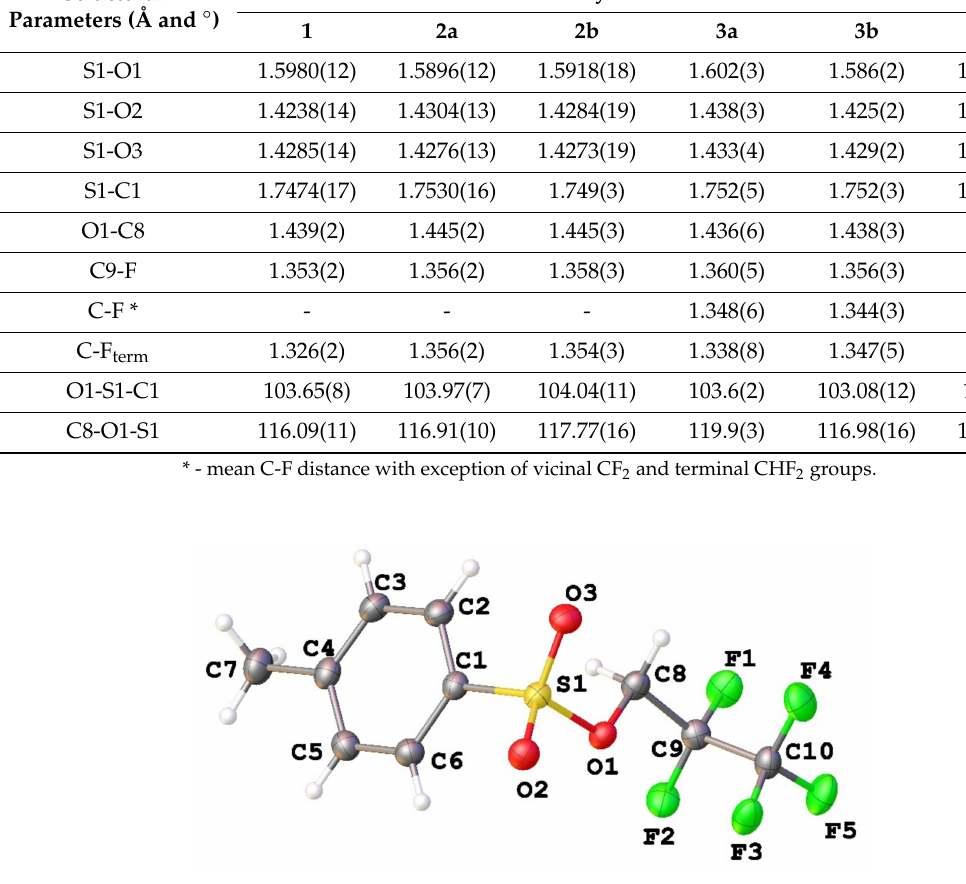
Figure 1. Molecular structure of 1 . Atoms are presented as thermal ellipsoids.